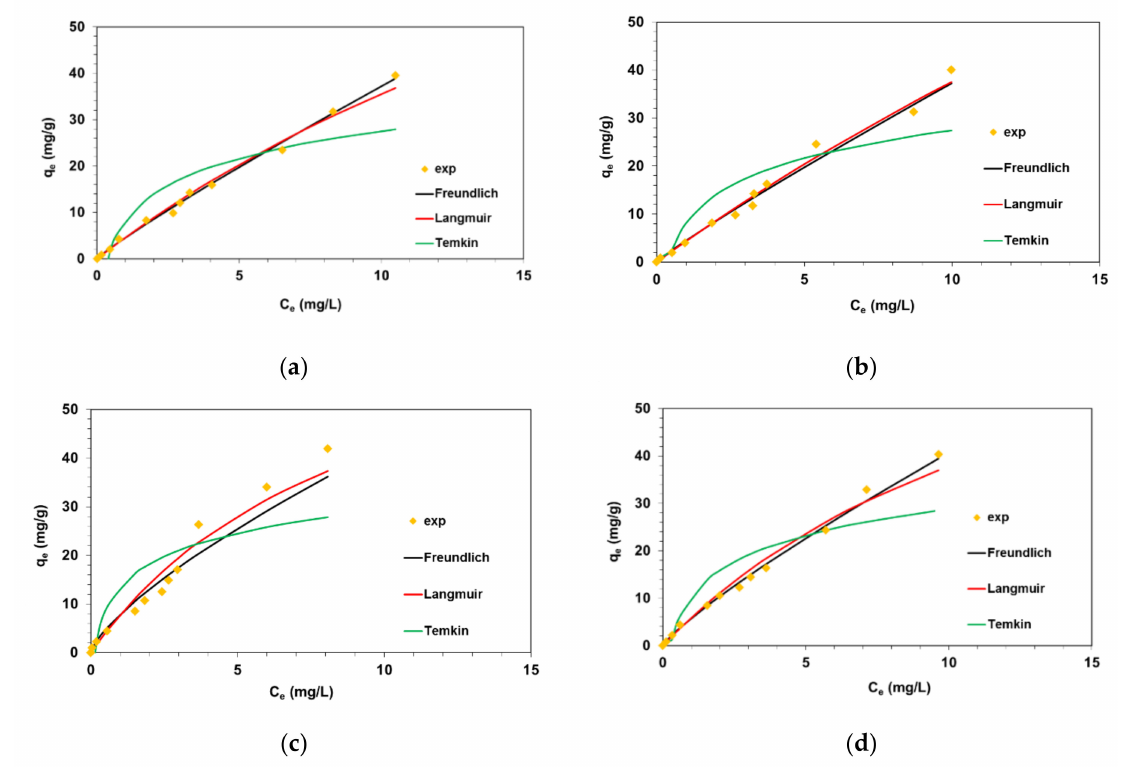
Figure 6. Fitting of isotherm models to the AO dye adsorption equilibrium data on ( a ) poly(DVB), ( b ) DVB-VBCl, ( c ) poly(EGDMA) and ( d ) EGDMA-VBCl.